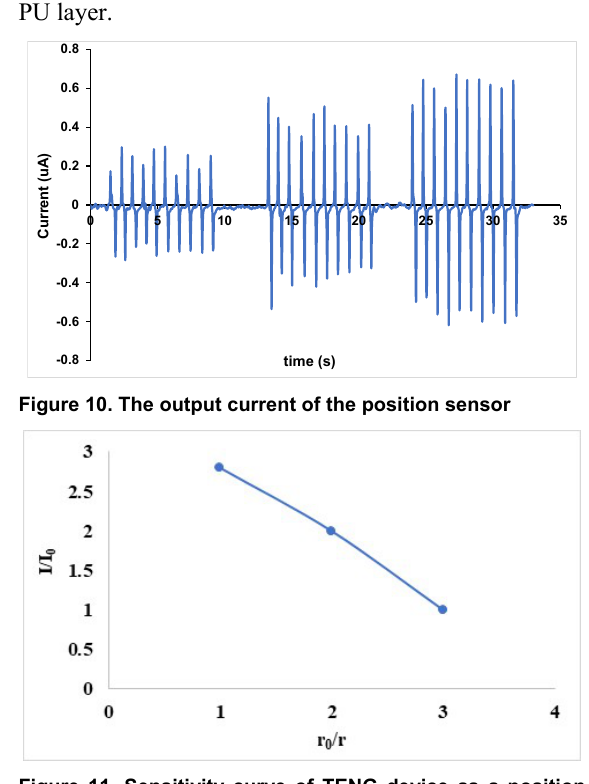
Figure 11. Sensitivity curve of TENG device as a position